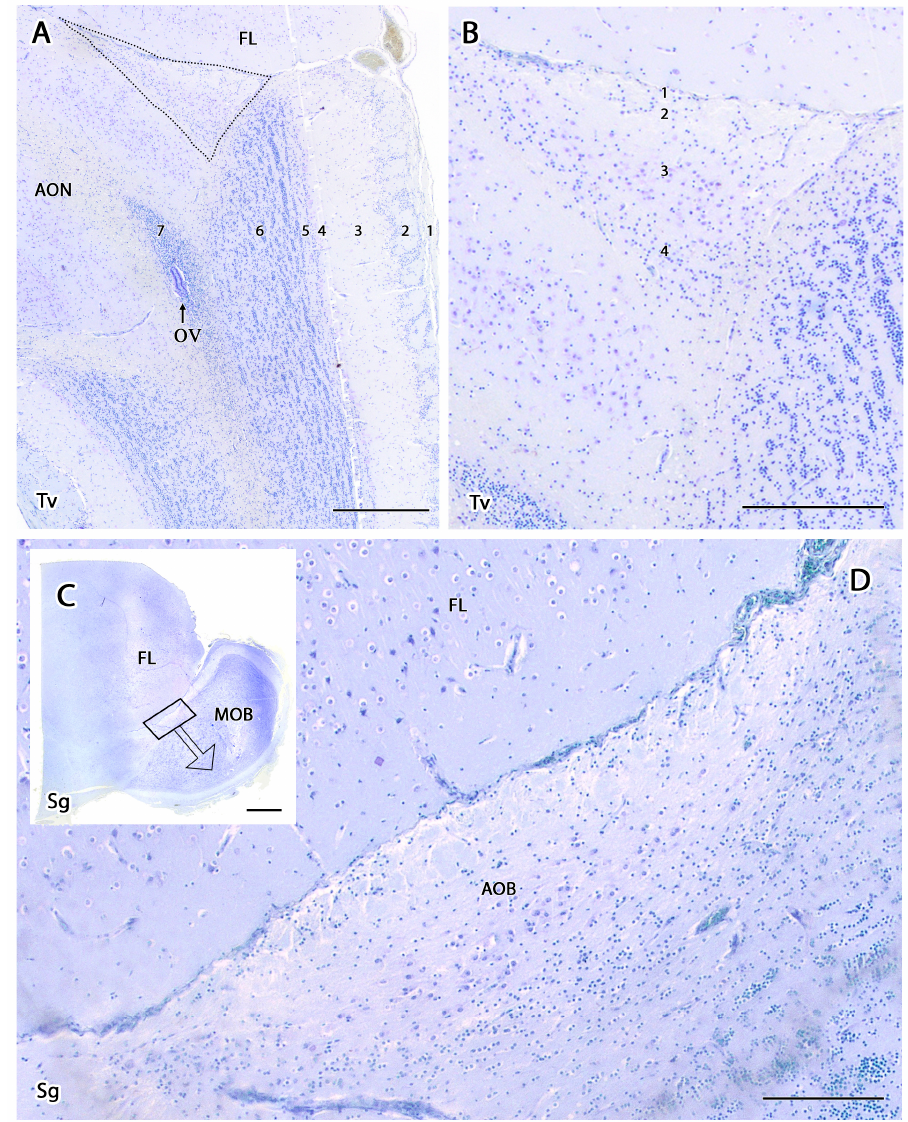
Figure 4. Histological study of the accessory olfactory bulb of the meerkat with Nissl staining. ( A ) Transverse section of the olfactory bulb showing the projection area of the accessory olfactory bulb (AOB) (delimited by dots), the lamination of the main olfactory bulb and the anterior olfactory nucleus (AON). The numbering of the layers is identical to that employed in Figure 2. ( B ) Enlargement of the AOB shown in A with its different layers numbered. 1, Vomeronasal nerve layer; 2, Glomerular layer; 3, Mitral-plexiform layer; 4, Granular layer. ( C ) Sagittal section of the olfactory bulb and the frontal lobe (FL) of the telencephalon showing the lamination of the main olfactory bulb (MOB) and the presence of the AOB in its caudomedial part. ( D ) Enlargement of the box in ( C ) showing the histology of the AOB. OV, olfactory ventricle. Scale bars: ( A ) 400 μ m; ( B ) 200 μ m; ( C ) 1200 μ m; ( D ) 150 μ m.